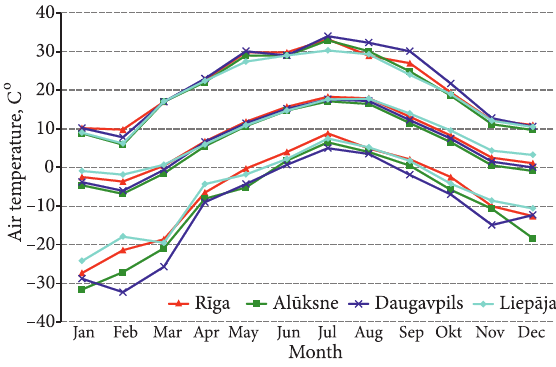
fig. 2. Monthly values for the max, min and average air temperatures in Riga and other major cities in